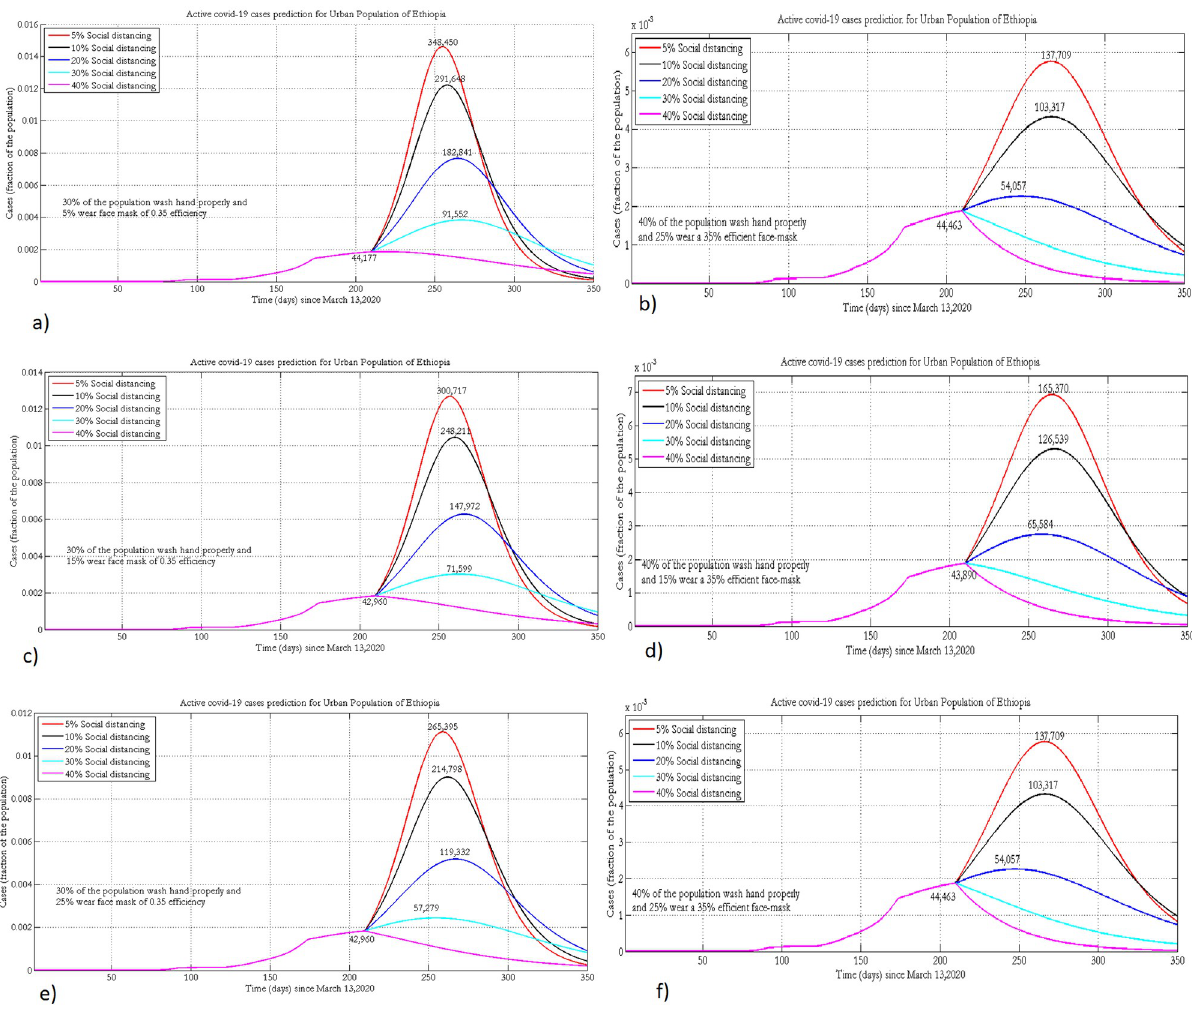
Fig 2. Projection of active COVID-19 cases in the urban population of Ethiopia where 30% or 40% practice hand washing and 5% (a, b), 15% (c, d) or 25% (e, f) of the population wear face masks, with 35% efficacy.